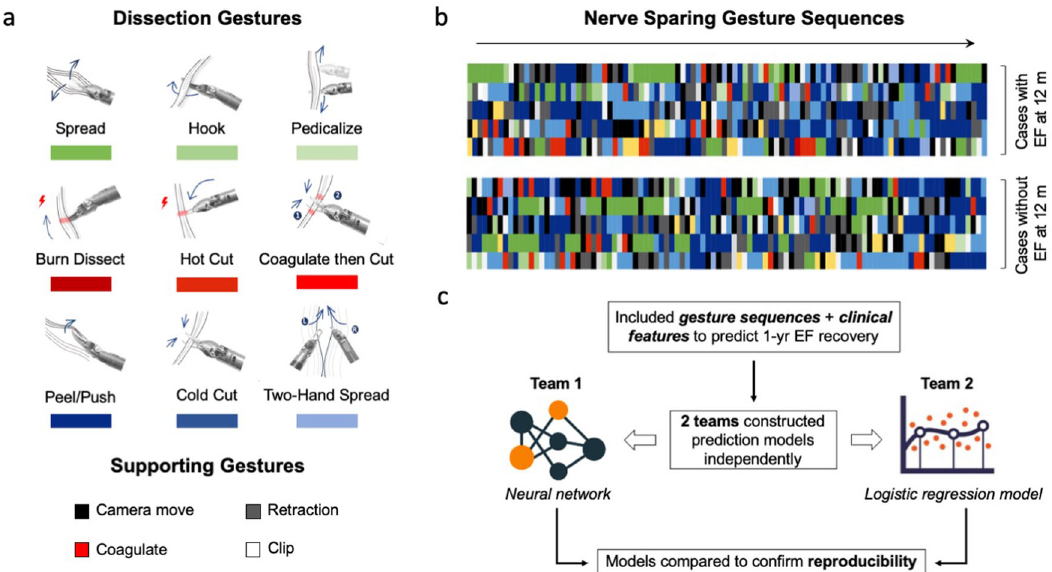
Fig. 1 Dissection gestures and the study design. a Gesture classi fi cation, including 9 dissection gestures and 4 supporting gestures. b Color- coded nerve-sparing gesture sequences (showing only the fi rst 100 gestures). Colors represented corresponding gestures in a . c One-year EF recovery prediction model construction process. Two teams independently constructed and tested their prediction models to con fi rm the reproducibility of results.